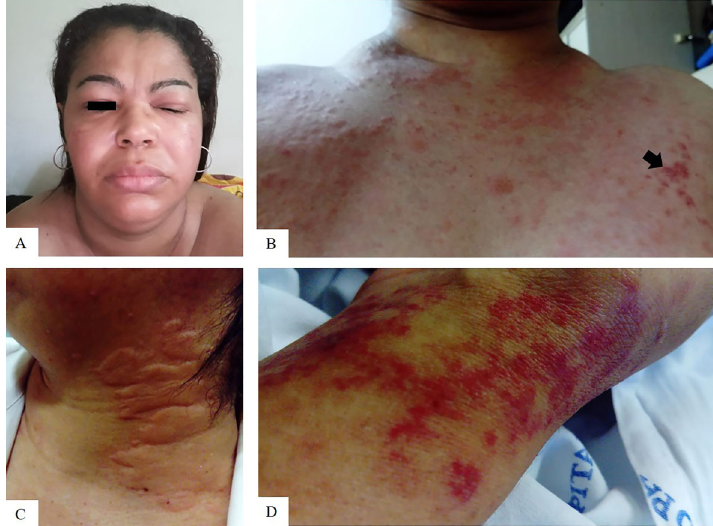
Figure 1. A , Asymmetrical facial angioedema. Angioedema was more prominent on the cheek and eyelid. B , Presence of hives on the thorax. Pruritic and painful purplish papules were observed on the left anterior thorax (black arrow). C , Urticarial circles that emerged on the lateral neck. D , Painful purplish macules can be seen, suggesting